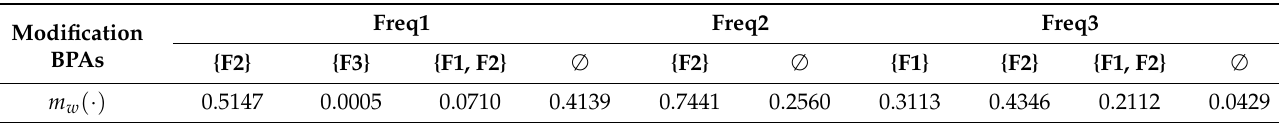
Table 10. Modification BPAs based on the proposed method.